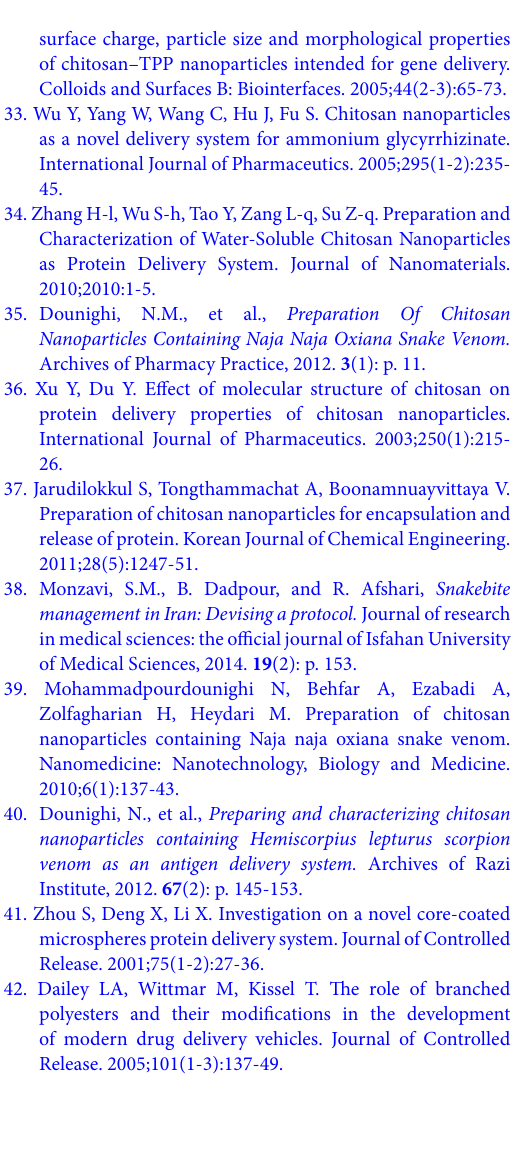
227 Nanomed Res J 4(4): 220-227, Autumn